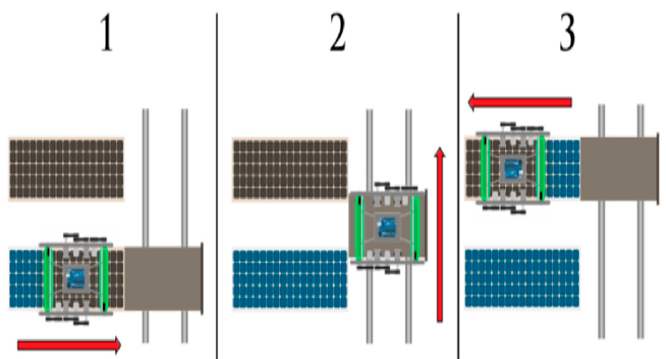
Figure 4. Robot system operation sequence [21].